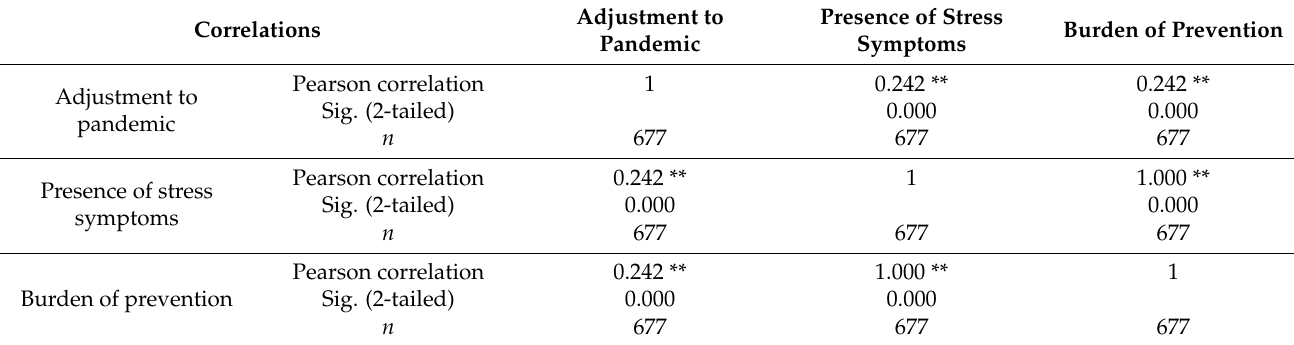
Table 3. Correlations between dependent